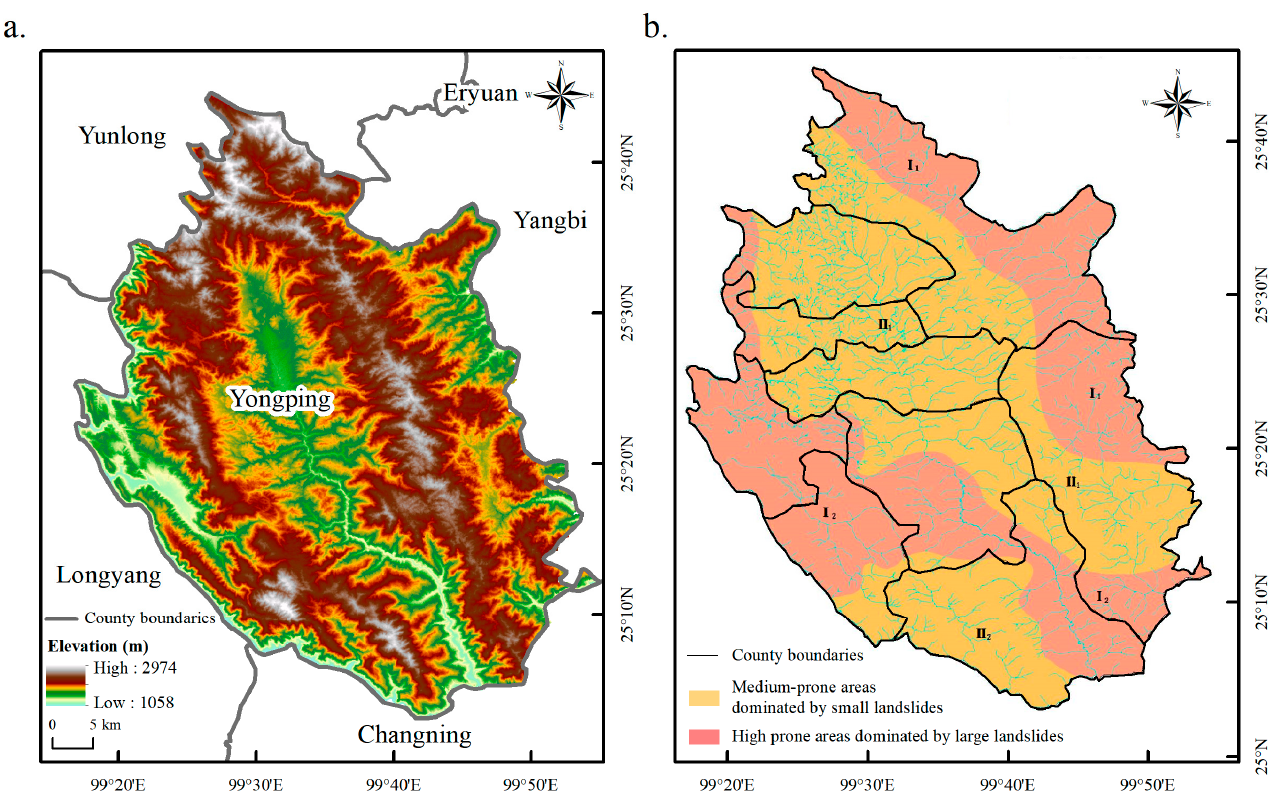
Figure 2. Schematic diagram of the experimental area. ( a ) Elevation range and ( b ) landslide prone areas.